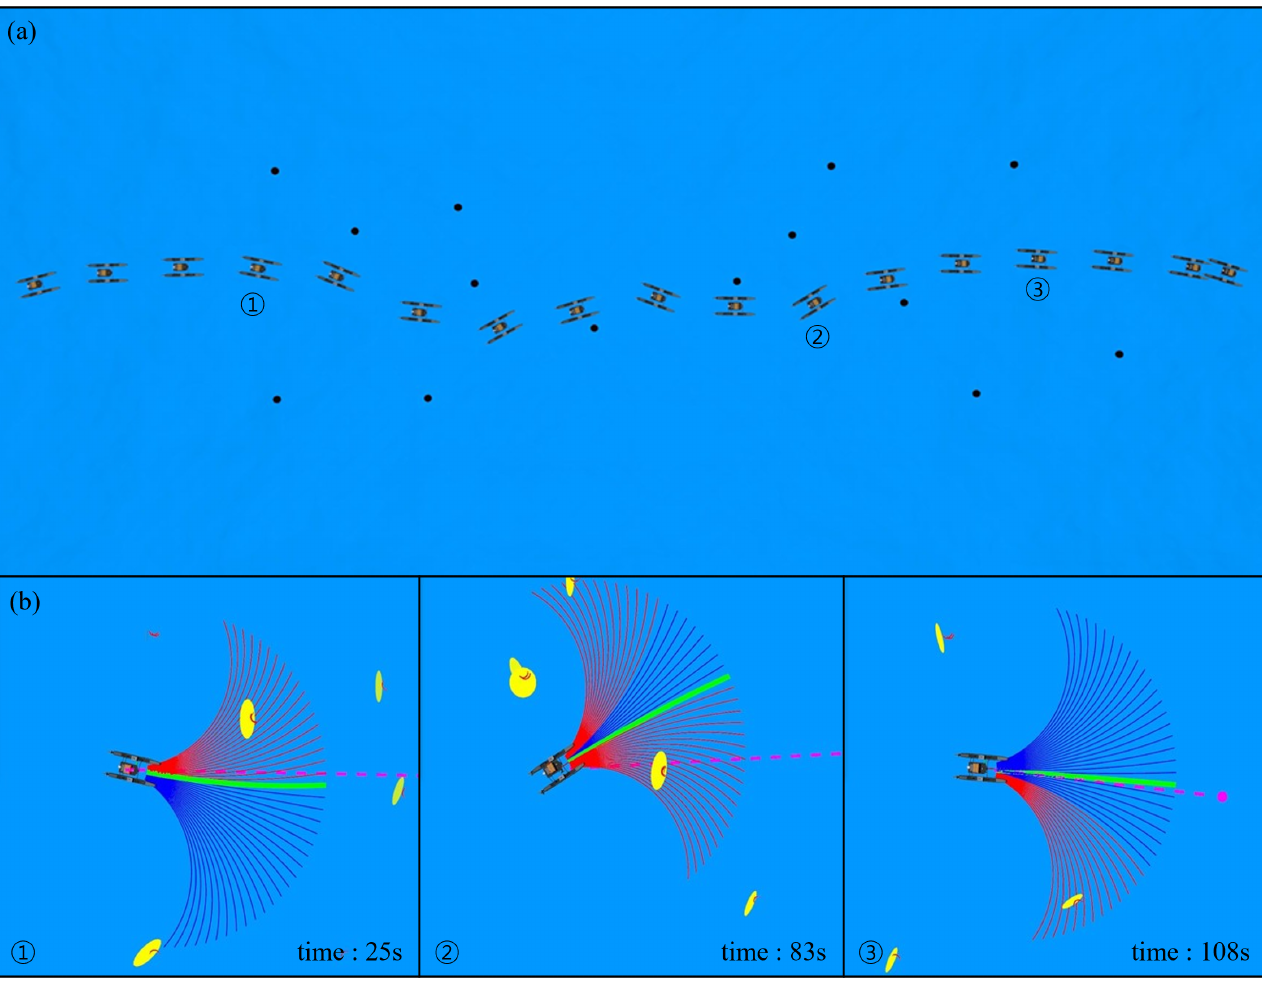
Figure 12. Results of ship trajectory and GMM mapping for stationary obstacles.( a ) Trajectory of the USV expressed in Gazebo; ( b ) Virtual information around the USV expressed in